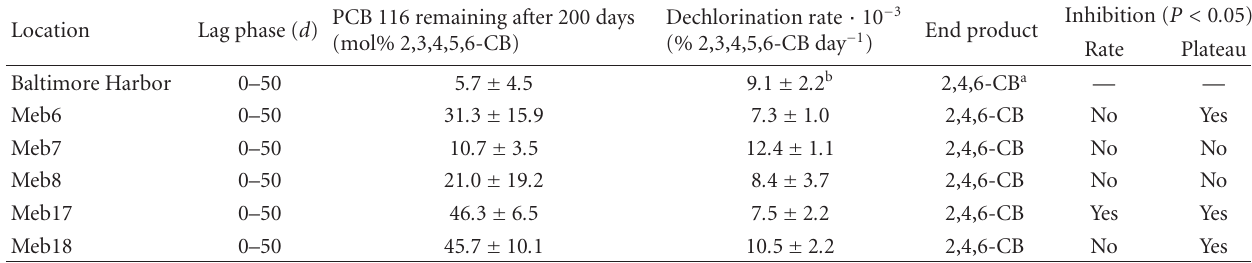
— 98 — a Mean values are given and figures in brackets are standard deviations ( n = 3). b The products 2,3,4,6-CB/2,3,5,6-CB coeluted during GC analysis. c This product was detected in one of three replicate cultures < 5 mol%. Table 4: E ff ect of inhibition on the dechlorination activity in microcosms using selected soil and sediment samples mixed 1:1 with actively dechlorinating sediment from Baltimore Harbor. Inhibition was determined ( P < 0 . 05) for the dechlorination rate and terminal plateau. Lag phase is defined as not showing activity that is di ff erent from the autoclaved negative control.